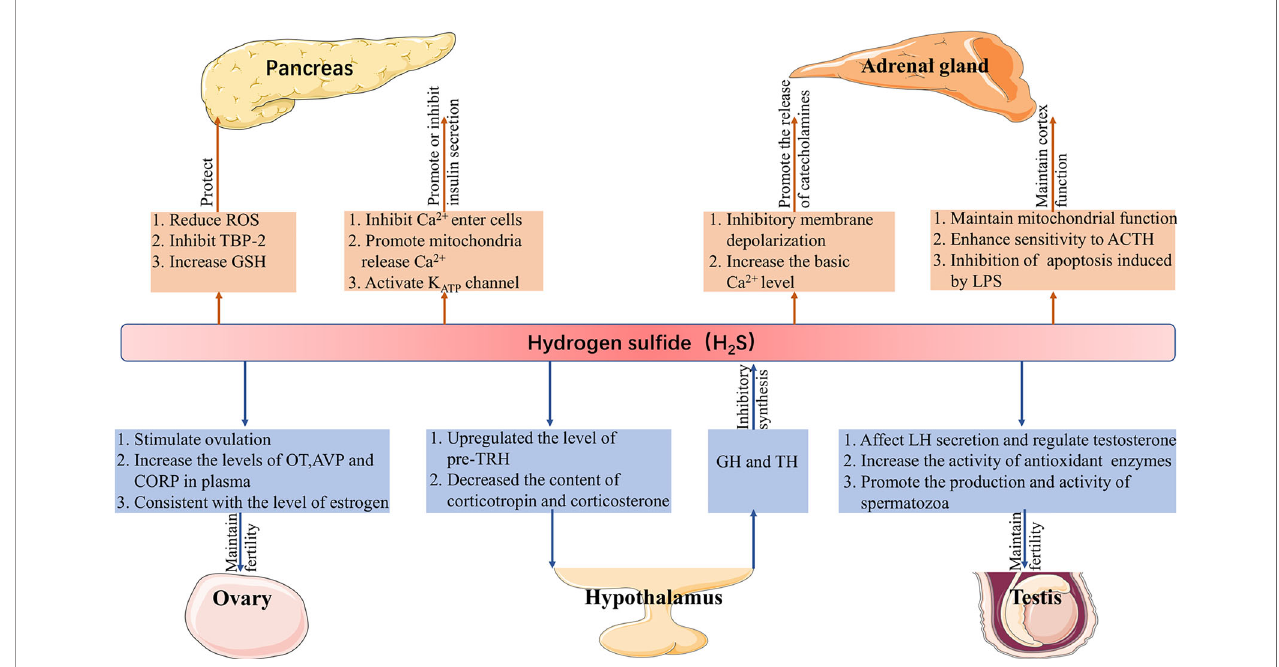
FIGURE 1 | Function of H2S in the endocrine system. H2S, hydrogen sul fi de; ROS, reactive oxygen species; TBP-2, thioredoxin binding protein-2; GSH, glutathione; ACTH, adrenocorticotropic hormone; LPS, lipopolysaccharide; LH, luteinizing hormone; pre-TRH, pre-thyrotropin-releasing hormone; GH, growth hormone; TH, thyroid hormone; OT, oxytocin; AVP, vasopressin; CORT,